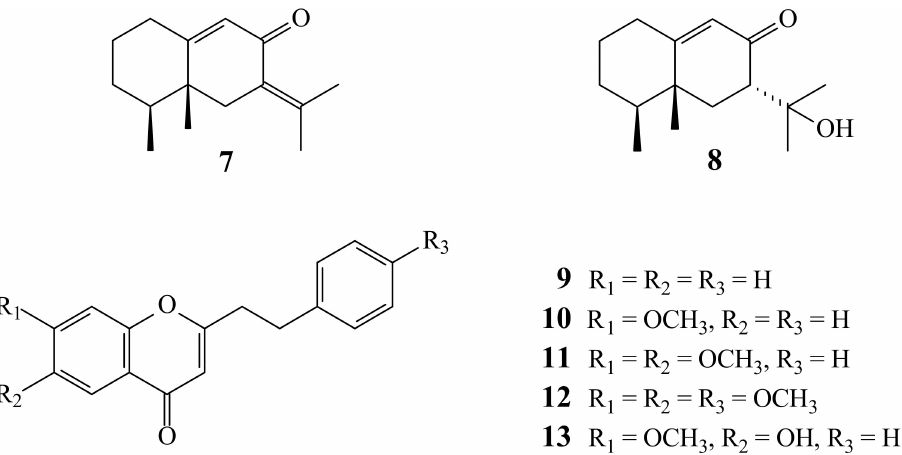
Figure 1. The chemical structures of compounds 1 – 13 isolated from A. sinensis.